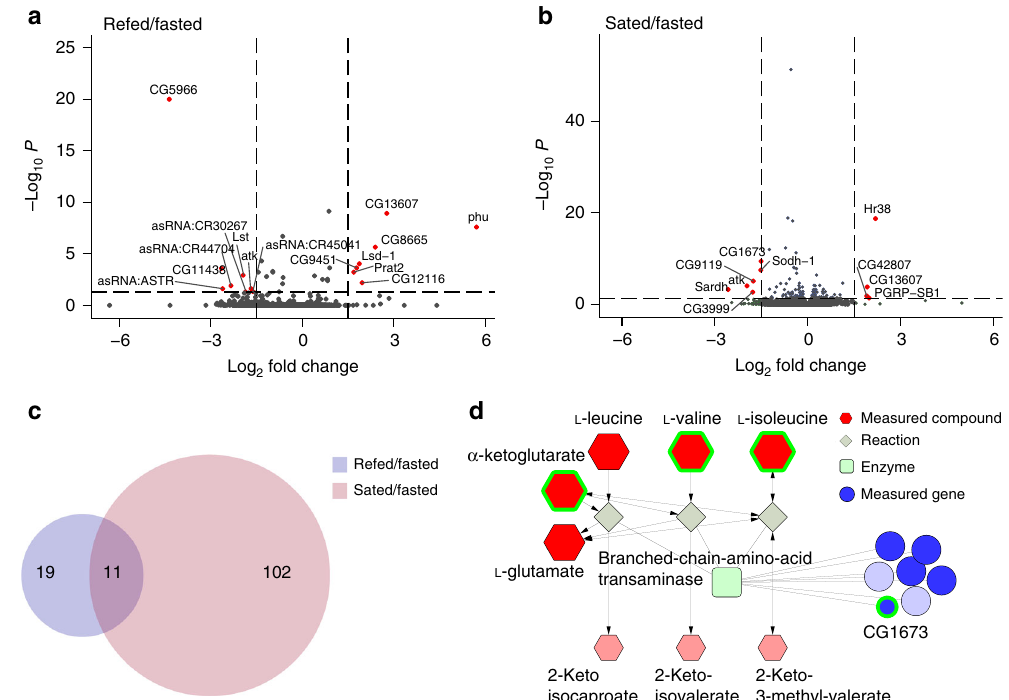
Fig. 3 RNA abundance changes of genes involved in nutrient transport and metabolism with refeeding. a, b Volcano plots showing the signi fi cant changes (Wald test, FDR < 0.05) in transcript levels between a refed vs. fasted and b sated vs. fasted brains. See main text and Methods for details on the feeding manipulations. The horizontal dotted line de fi nes the p- value cutoff of 0.05, and the vertical lines indicate a log 2 fold change of ±1.5. Red circles indicate transcripts that pass p -value and log 2 fold cutoffs. c Venn diagram showing the overlap in the transcripts that change between the refed/fasted (purple shade) and the sated/fasted (pink shade) conditions. d A partial Flyscape network made using both the metabolomics (Fig. 2) and the RNA-sequencing data (this fi gure) showing the metabolites and genes that change between the fasted and refed conditions in branched-chain amino acid metabolism. The size of the compound nodes (red hexagons) re fl ects changes in metabolite abundance (up or down) between refed and fasted fl ies, and salmon-colored hexagons represent compounds that were not measured. The size of the gene nodes (blue circles) represent the sign of changes in RNA abundance between fasted and refed fl ies, (light blue circles are genes that were not measured). Green squares represent the enzyme type. Compounds with an FDR < 0.1 by Welch ’ s t -test and genes with a corrected p -value < 0.05 by Wald test are outlined in green. Source data are provided as a Source Data fi